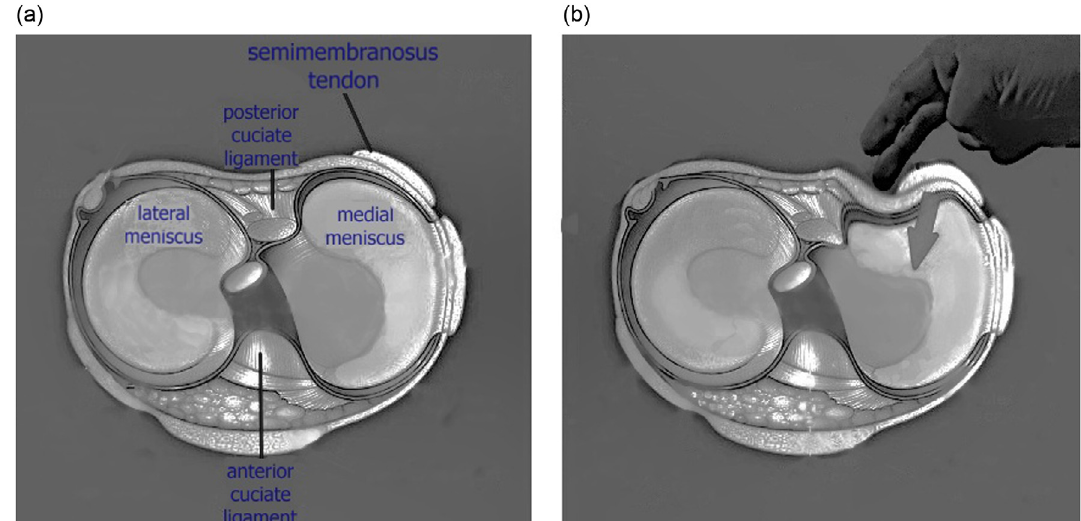
Figure 1. (a, b) The assistant places the middle or index finger on the posterior knee surface just medial to the semimembranosus tendon at the level of the joint line, and applies anteriorly directed pressure delivering the posterior horn of the medial meniscus into view.